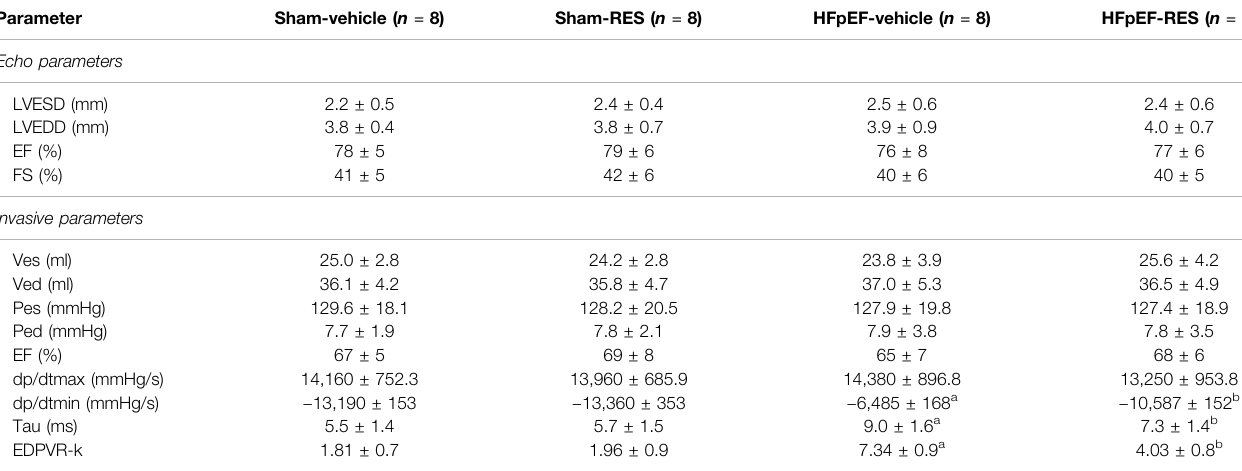
TABLE 2 | Echocardiography and invasive parameters of Sham or HFpEF mice 4 weeks after Vehicle or RES administration.